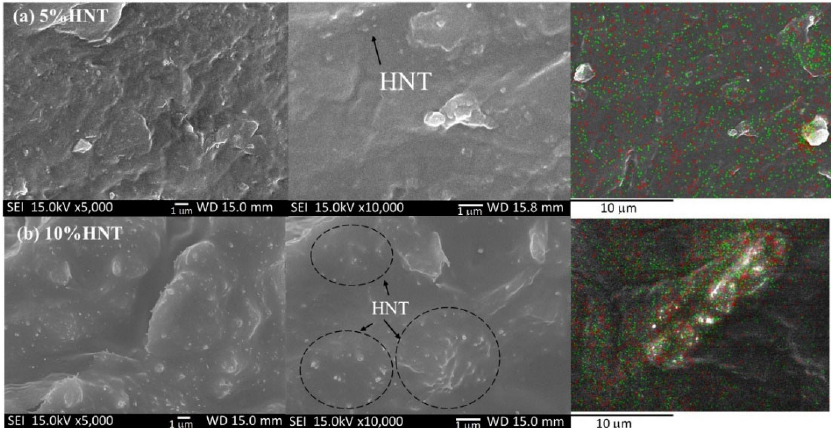
Figure 3. SEM micrographs of fracture surfaces of the Non − US prepared PEO-20%LiCF 3 SO 3 with ( a ) 5%HNT, ( b ) 10%HNT at ×5000, ×10,000 and EDS mapping of Al (red), Si (green), respectively. Ultrasonication was applied to the PEO-20%LiCF 3 SO 3 -5%HNT and the PEO-20%LiCF 3 SO 3